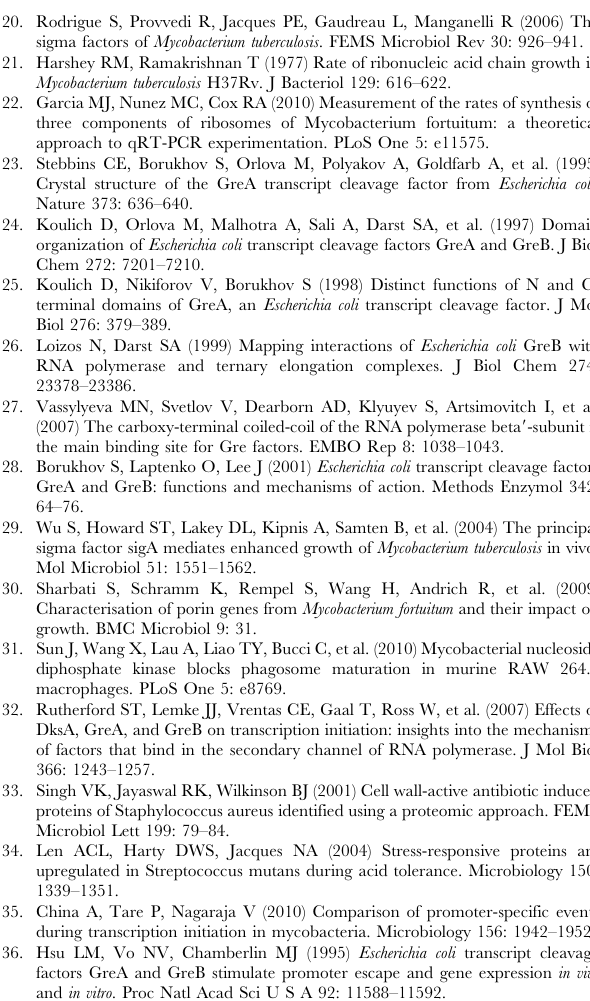
Figure S4 Ms and Mtb RNAP are free from endogenous Gre factor contamination. 20 m g of both Ms and Mtb RNAP were probed with anti-Gre antibody. 100 ng of purified Mtb Gre was used as a control. Figure S5 Activity of Ms Gre and the phenotypic effects of gre overexpression. ( A ) Transcript cleavage stimulatory activity of Ms Gre. ( B ) SDS-PAGE analysis of the cell lysates from M. smegmatis with pMV261, with the over-expression construct (pMV greOE ) and antisense (pMV greAS ) mediated knock-down construct. ( C ) Morphology of the M. smegmatis cells over-expressing Mtb Gre. Comparison of cellular morphology (left panel) and nucleoid (right panel) of M. smegmatis mc 2 155 cells harboring either the pMV261 vector or pMV- greAS or pMV- greOE constructs. Left panels- bright-field images; right panels-fluorescent images showing the DAPI-stained nucleoid. Figure S6 Determination of the expression pattern of Gre and its amount in the cells. ( A ) Expression of gre in response to different stresses in M. smegmatis and M. tuberculosis determined by western blot. ( B ) Estimation of the level of Gre protein in the M. smegmatis cells. Purified M. smegmatis Gre protein was used as a standard. 120 m g of total cell lysate proteins were